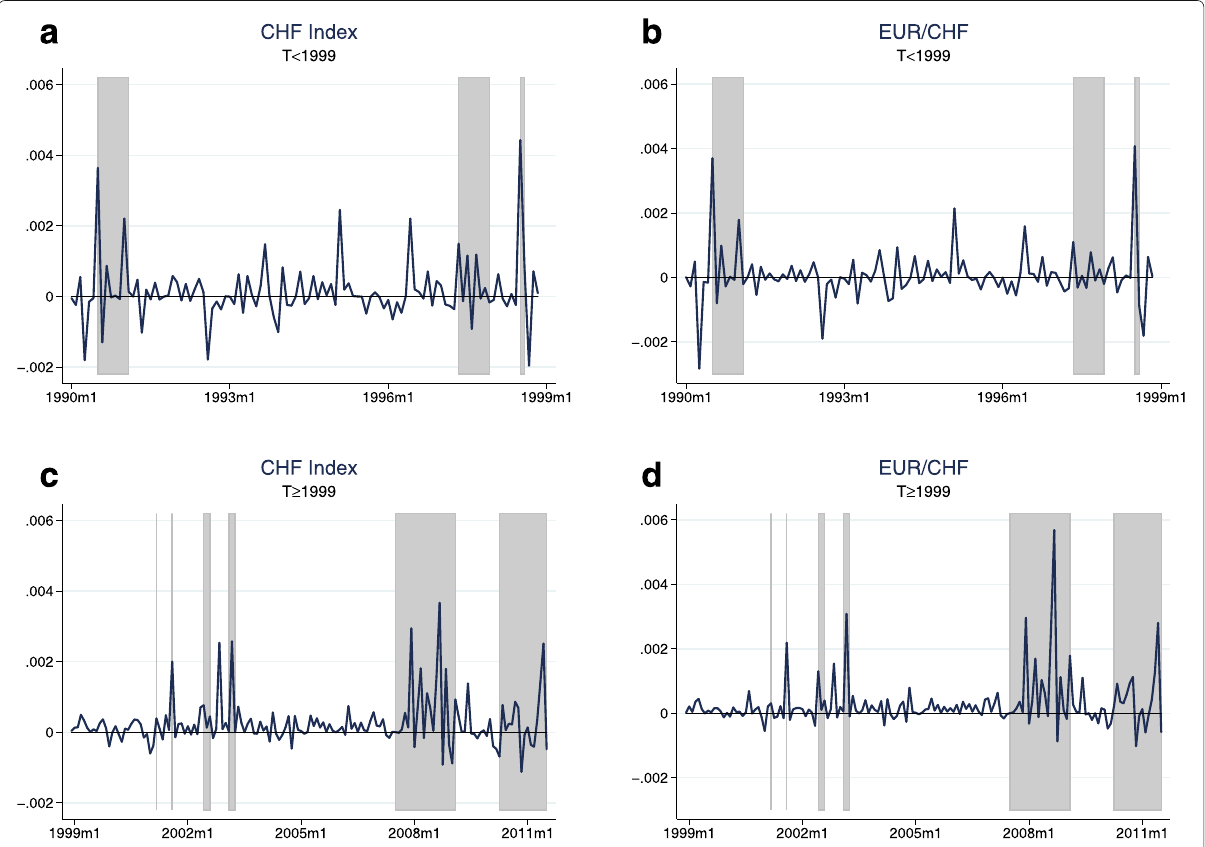
Fig. 4 ( a - d ) Ex-post covariance—subsamples. Notes: The estimates of the ex-post covariance are calculated as the product of the residuals of the (cid:6) (cid:7) ≡ ˆ (cid:7) r ˆ (cid:7) e ˆ (cid:7) r ˆ (cid:7) e r ω t + 1 , (cid:2) e t + 1 zero stage regressions: (cid:12) Cov t t + 1 , where t + 1 are the residuals in equations (6) and (7). The zero stage regressions are t + 1 t + 1 and estimated for each subsample separately. The first subsample (January 1990 to December 1998) consists of 107 observations and the second subsample (January 1999 to August 2011) consists of 152